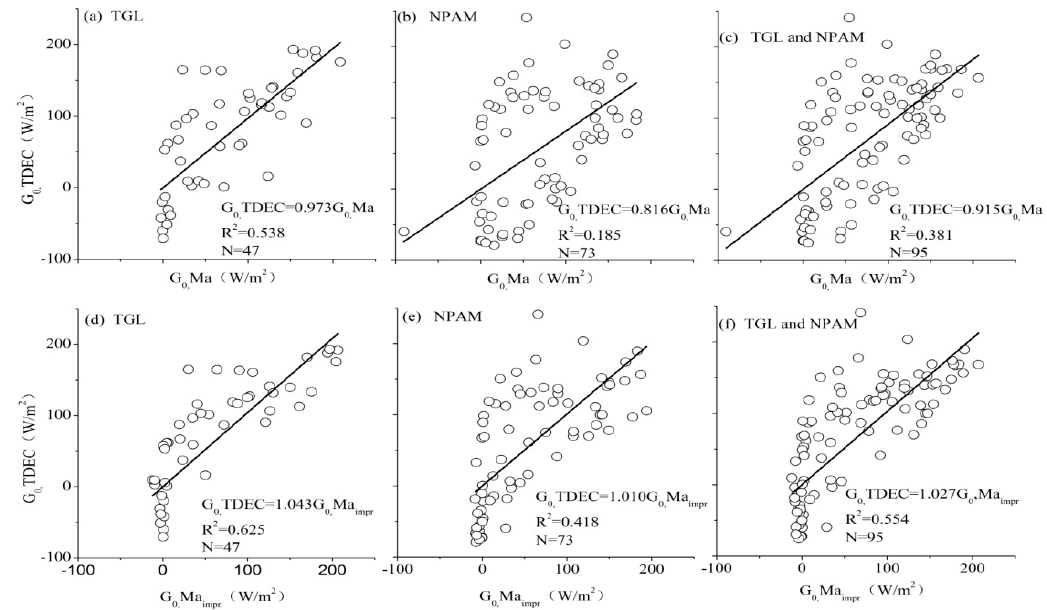
Figure 13. Comparison between the Ma impr and Ma schemes at each site